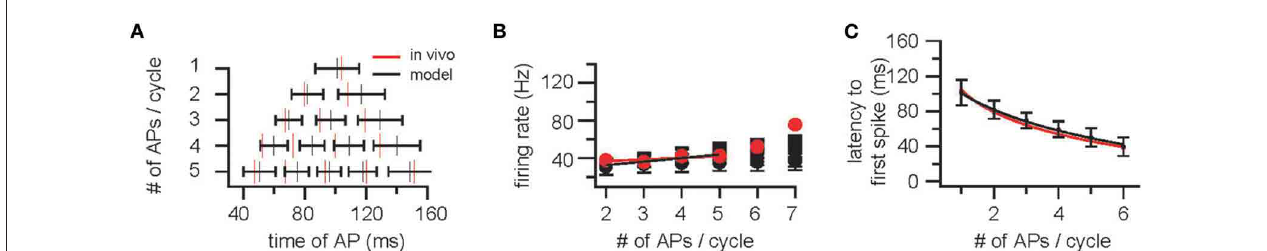
sniff cycles that evoke between 1 and 5 APs. (B) Instantaneous firing rate [inverse of the inter-spike interval (ISI)] and the latency to action potential (AP) onset (C) plotted against the number of APs evoked per sniff cycle. Red markers and lines indicate data obtained from M/TC whole-cell recordings in vivo [Margrie and Schaefer (2003)]. Black indicates the cellular responses for the integrate-and-fire (InF) neurons